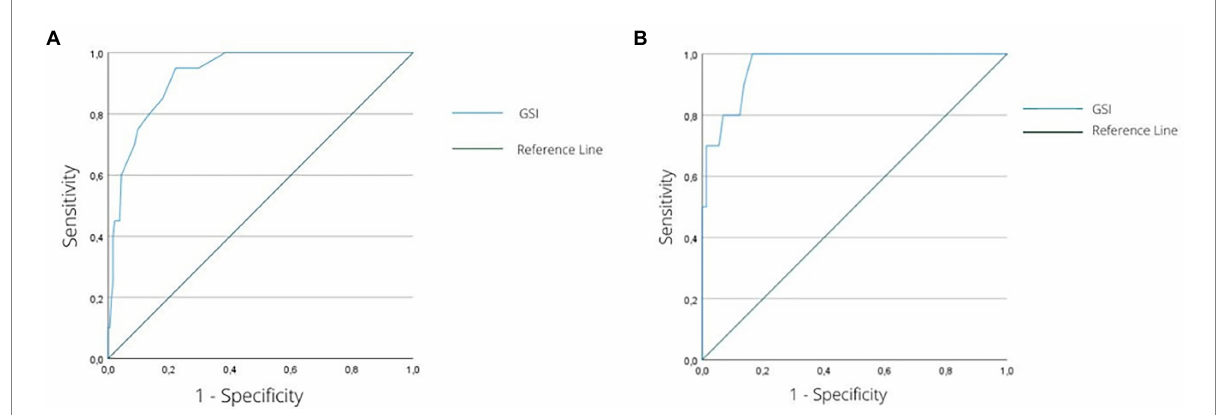
FIGURE 1 (A) ROC curve graph for the ability of the GSI to discriminate female individuals with significant psychological distress levels (GHQ-12 score 7+) from those without a significant level of psychological distress (GHQ-12 < 7). (B) ROC curve graph for the ability of the GSI to discriminate male individuals with significant psychological distress levels (GHQ-12 score 7+) from those without a significant level of psychological distress (GHQ- 12 < 7). ROC, receiver operating characteristic; GSI, global severity index of the Symptom Checklist-K-9; GHQ-12, 12-item General